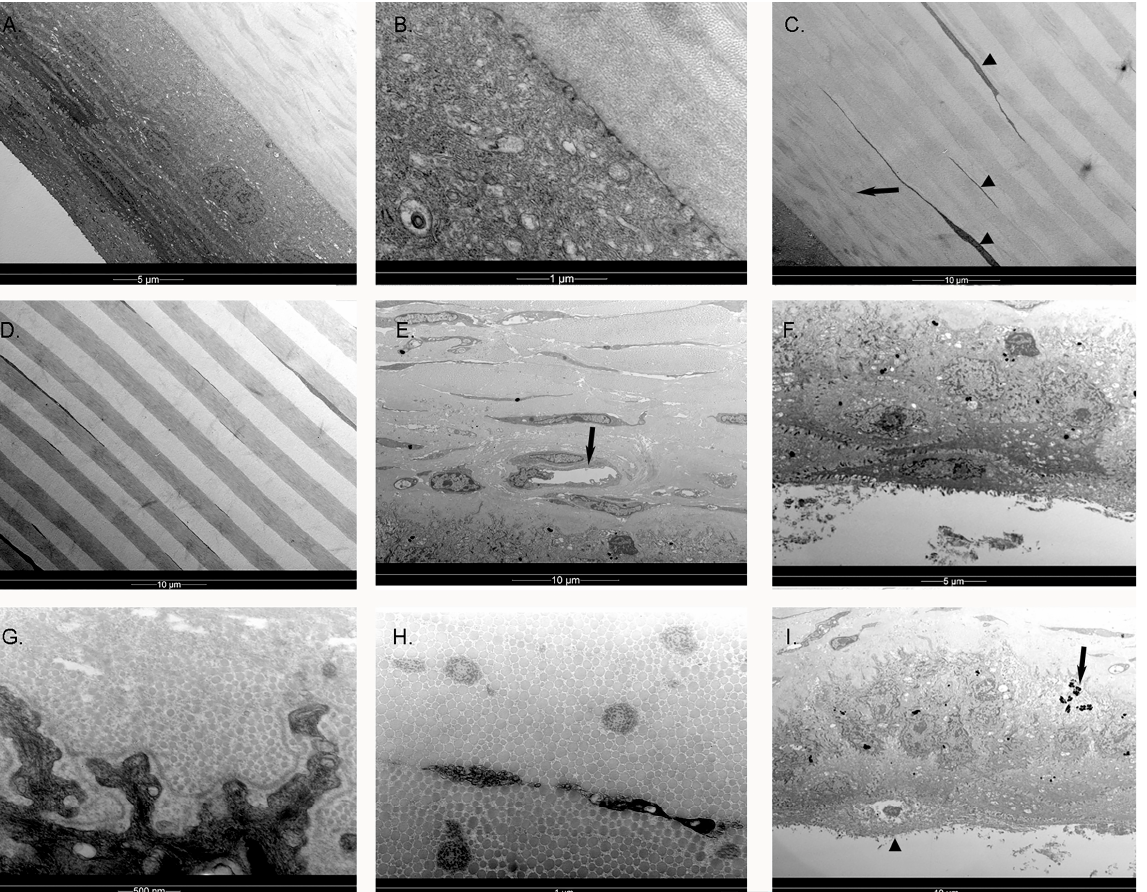
Figure 4. The left cornea of king penguin Aptenodytes patagonicus K2, examined by transmission electron microscopy. ( A ) Central cornea. The more superficial epithelial cells were flatter than the basal layer. An intermediate layer of wing cells as described in the human ( Homo sapiens ) cornea was not apparent centrally and vesicles were not as abundant in the superficial cells as in the human; ( B ) Higher power view, showing small interdigitations at the border between the basal epithelium and Bowman’s membrane in the central cornea. There were no anchoring fibrils or plaques; ( C ) There were interconnecting bands (lamellae, arrow) of collagen fibrils in the area of Bowman’s layer, but below the anterior 10 μ m of stroma, these bands only very infrequently interconnected. Each band was approximately the same thickness. The collagen fibrils were aligned at right angles to those in the preceding and succeeding bands. The stromal keratocytes (arrowheads) were extremely thin and predominantly located at borders between bands, although their processes occasionally crossed bands; ( D ) In the mid stroma of the central cornea, the collagen bands were slightly thicker. Interconnections between bands remained rare; ( E ) At the limbus, the bands became more irregular and anastomosed more frequently; capillaries were also seen (arrow), with an endothelial cell and pericyte. No fenestration was visible. However, each band was still orientated either perpendicular or parallel to the plane of section. Melanin granules are present in epithelial and stromal cells; ( F ) The limbal corneal epithelium appeared less flattened superficially and had more definite wing cells immediately superficial to the basal layer, similar to that described in the little penguin ( Eudyptula minor) and human. Multiple desmosomes interconnect all cells. A defined Bowman’s layer was no longer present; ( G ) High powered view of the limbal basal epithelium, showing more complex ep ‐ ithelial ‐ stromal interdigitations in the peripheral cornea than centrally. An electron ‐ dense granular basement membrane was present; ( H ) The collagen fibrils in the limbal stroma could be over 100 nm in diameter, although many wee smaller; ( I ) The equivalent of the epithelial rete peg of the human, forming part of the limbal Palisade of Vogt. Note the melanin granules (arrow) and more squamous superficial cells (arrowhead).